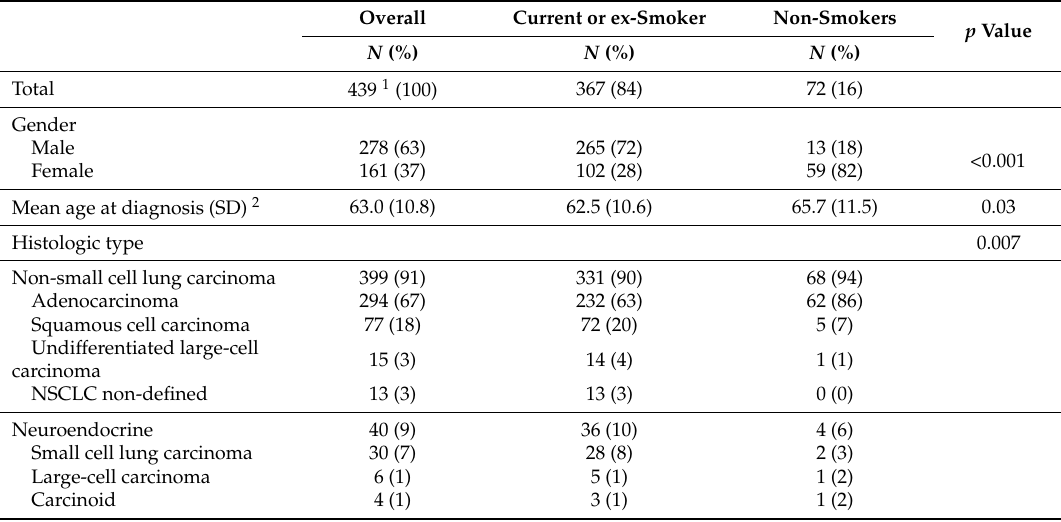
Table 1. Summary of patients’ characteristics overall and by smoking